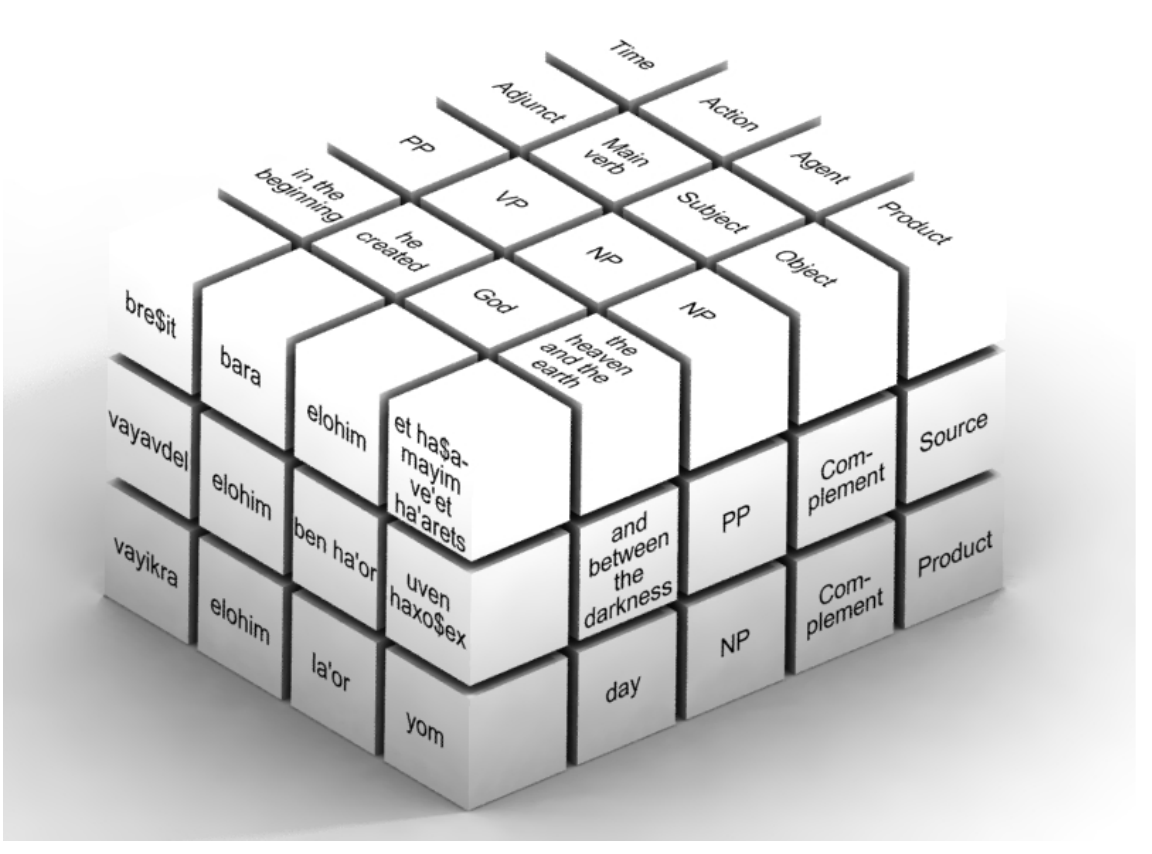
Figure 1. A clause cube containing real linguistic data of three Biblical Hebrew clauses, Gen. 1:1a, 4c and